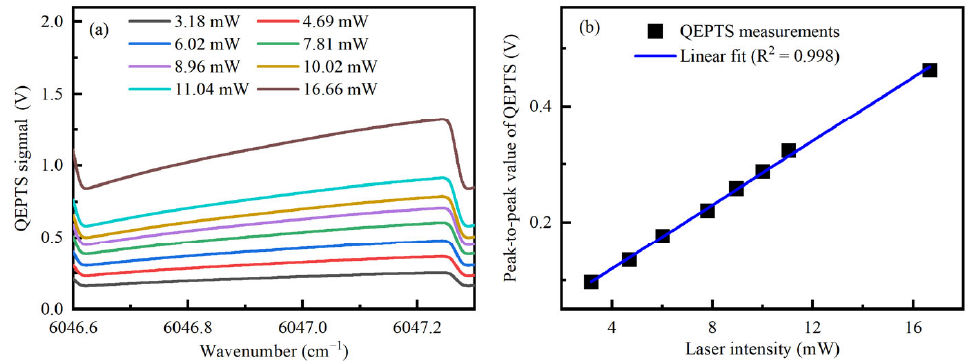
Figure 5. QEPTS system measurements at different light intensities. ( a ) The 1 f photothermal signal at different light intensities; and ( b ) linear fitting curve of the amplitude of the 1 f photothermal signal at different light intensities.